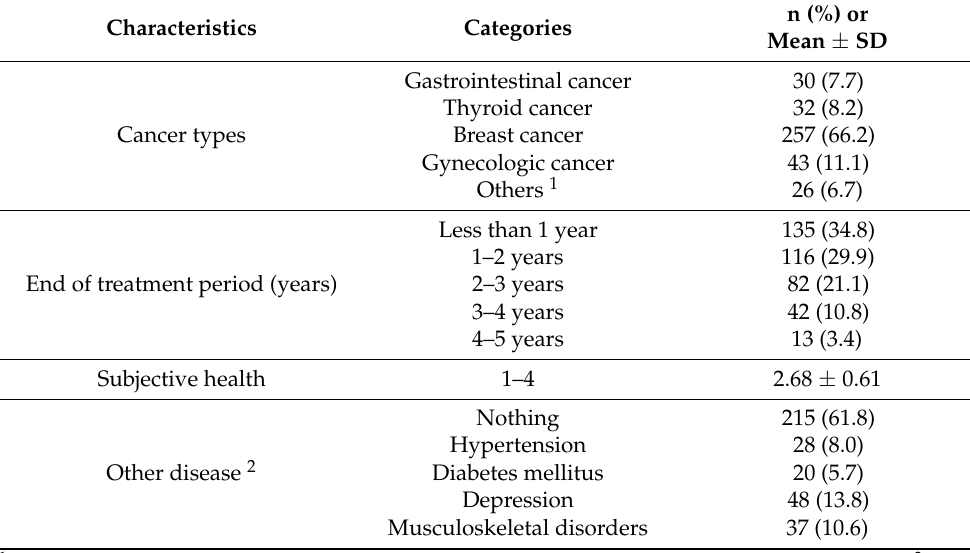
Table 2. Clinical characteristics (N =